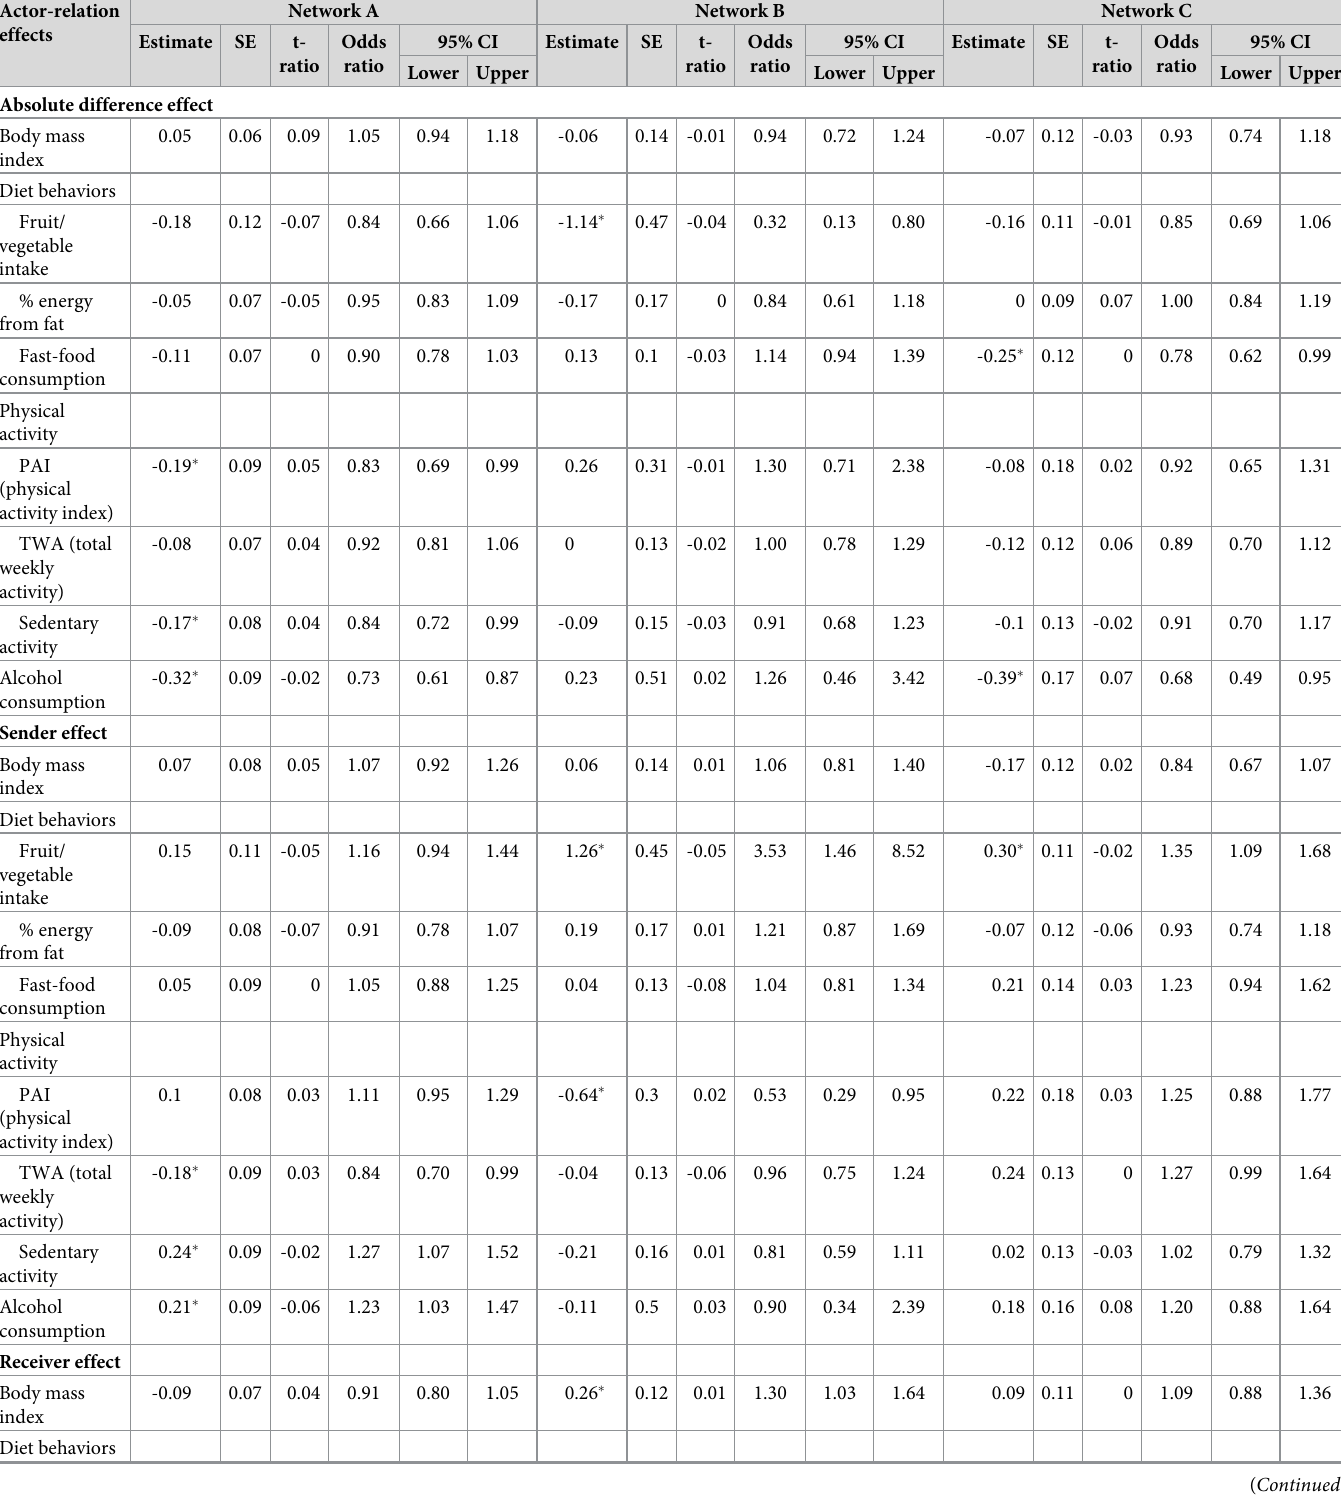
Table 3. The actor-relation effects on body mass index and obesity-related behaviors (with odds ratio and 95%